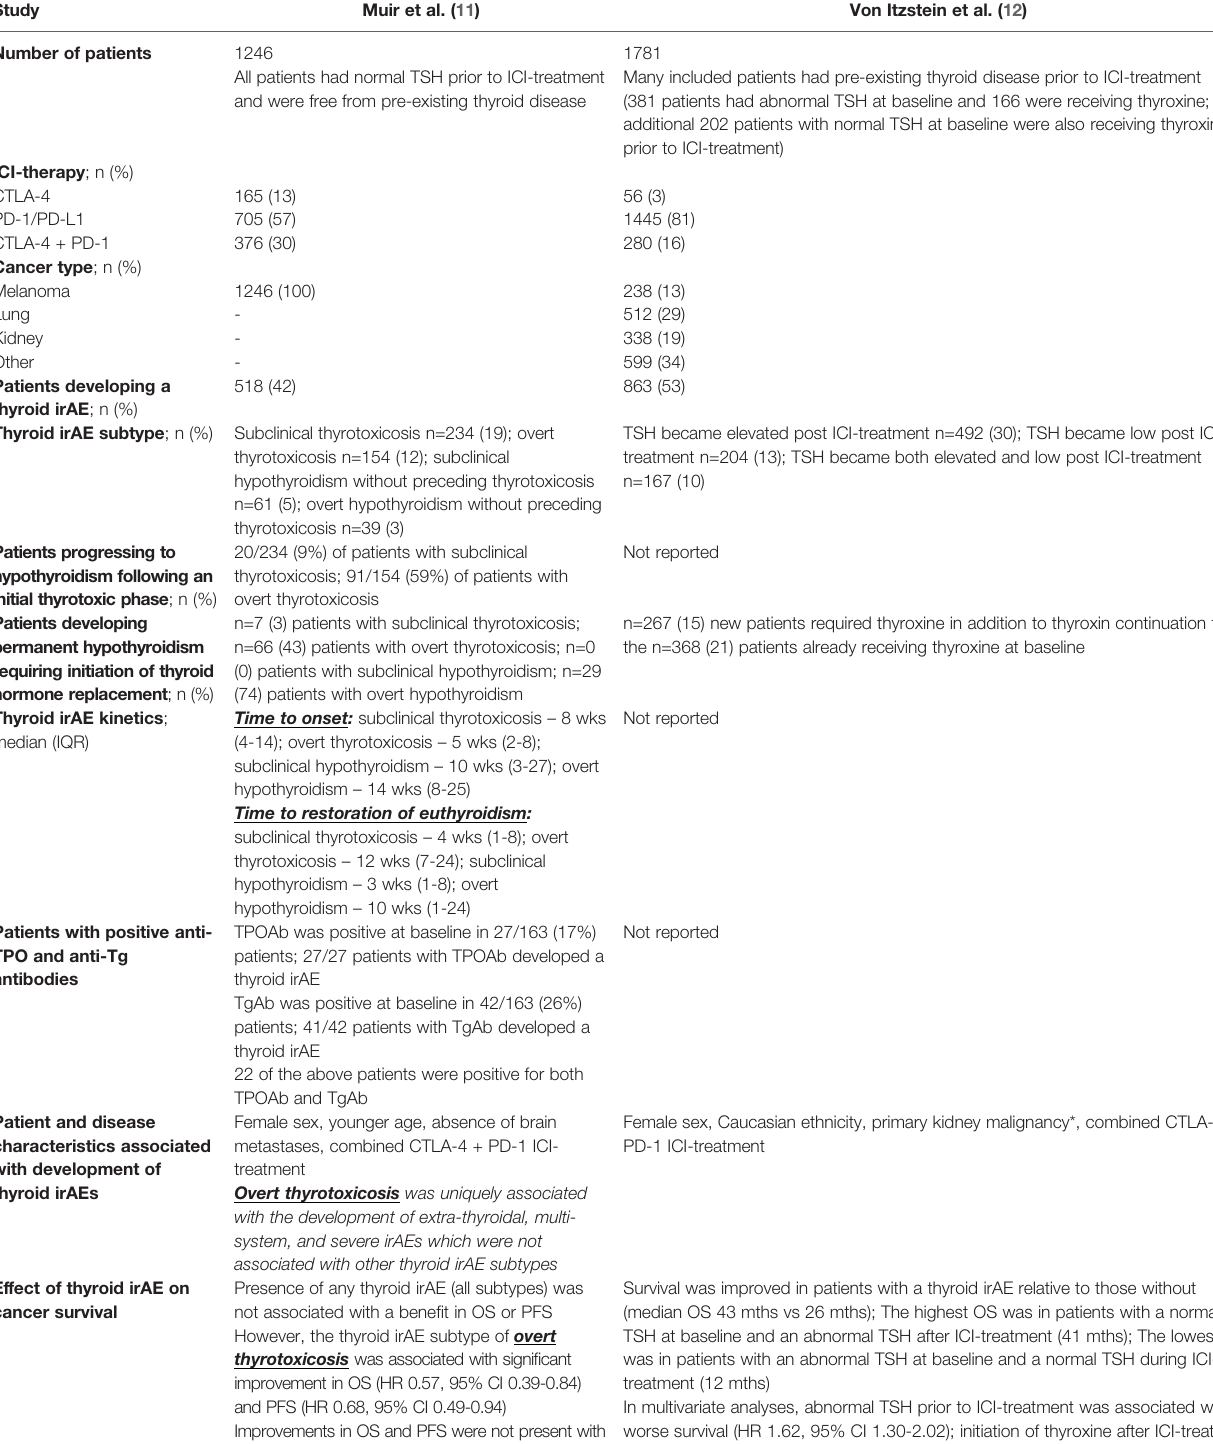
TABLE 1 | Summary of fi ndings from the two largest studies of thyroid irAEs.